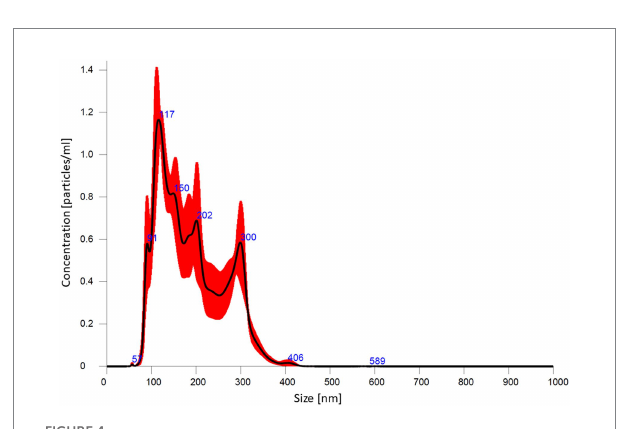
FIGURE 4 Silver nanoparticle size distribution from nanoparticle tracking